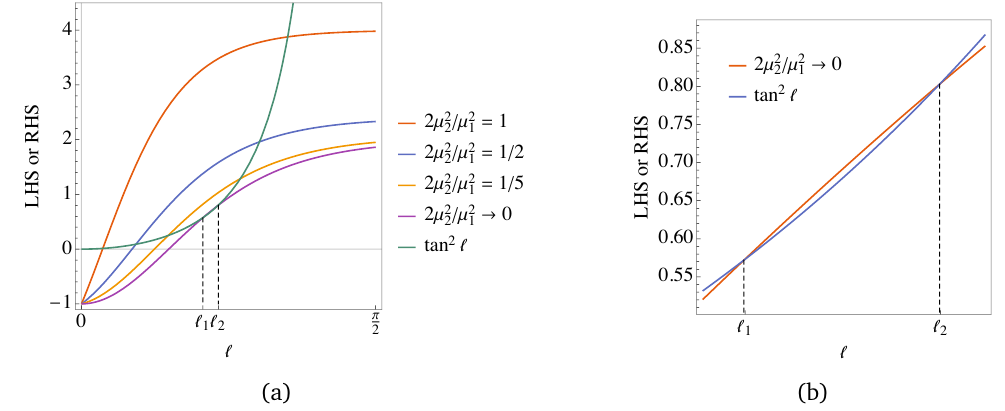
Figure 9: (a) Four cases of the LHS of equation (B.11) are plotted here. All of them have a range of (cid:96) where they are above the RHS (tan 2 (cid:96) ) curve. (b) Zoomed up /µ → 0, in which case the LHS of (B.11) corresponds to 3tanh 2 version of µ 2 1 (cid:112) 2 (cid:96) − 1, and it can be verified numerically that any (cid:96) LHS approaches 3tanh 2